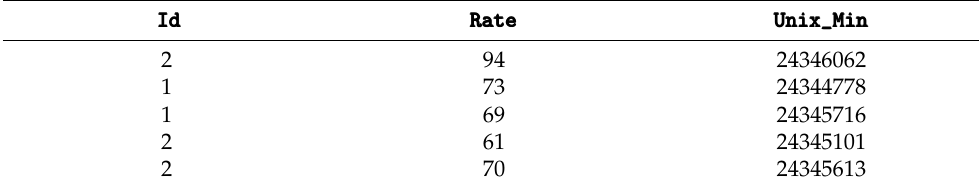
Table 1. Excerpt from the heart rate dataset which was used as the input for the synthesizers. IdIdId